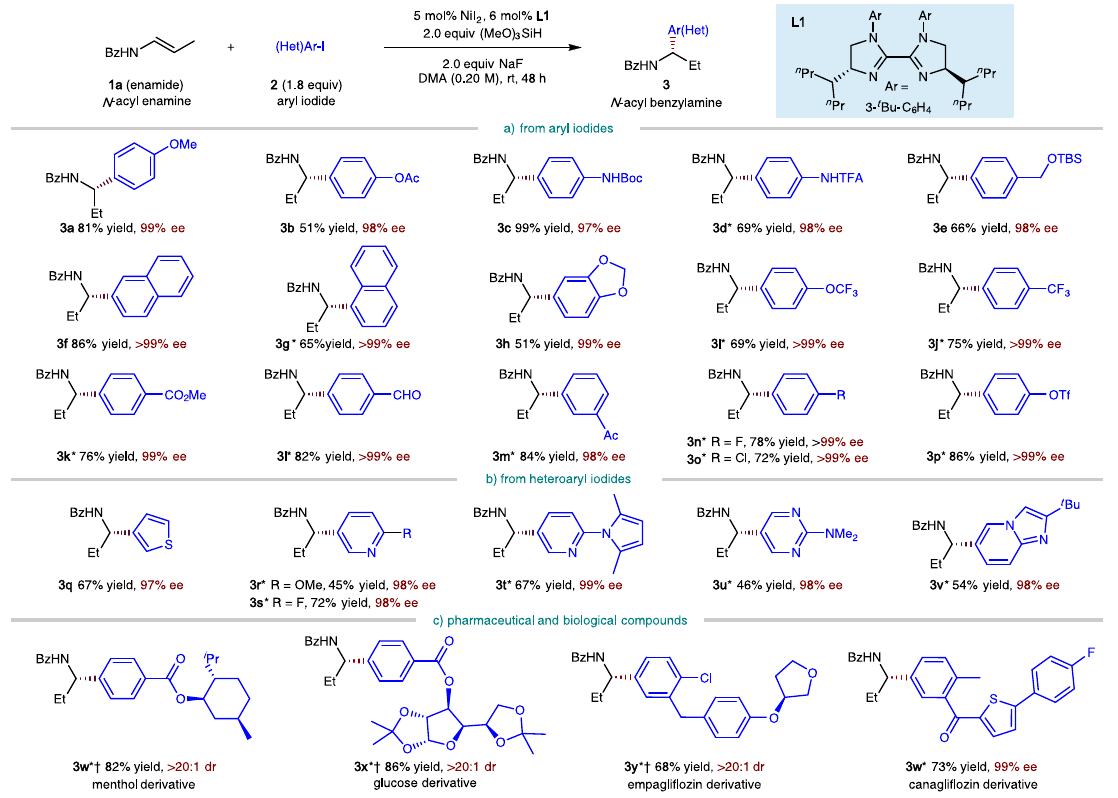
Fig. 3 Substrate scope of aryl iodide component. Yield under each product refers to the isolated yield of puri fi ed product (0.20 mmol scale, average of two runs), >95:5 regioisomeric ratio (rr) unless otherwise noted. Enantioselectivities were determined by chiral HPLC analysis. *5 mol% Ni(ClO 4 ) 2 ∙ 6H 2 O, DMA (0.10 M), 1.5 equiv ArI. † Diastereoisomeric ratio (dr) was determined by crude 1 H NMR analysis. TBS, tert -butyldimethylsilyl. NATURE COMMUNICATIONS| (2021) 12:638